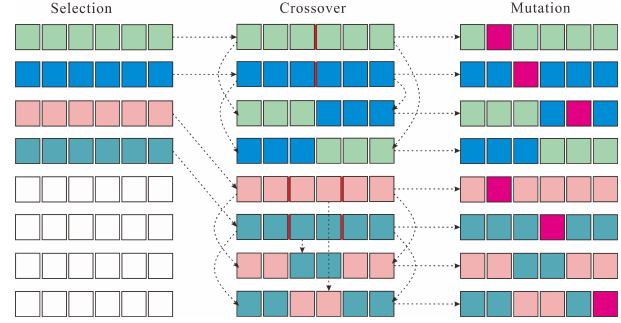
Figure 1. Diagram of genetic